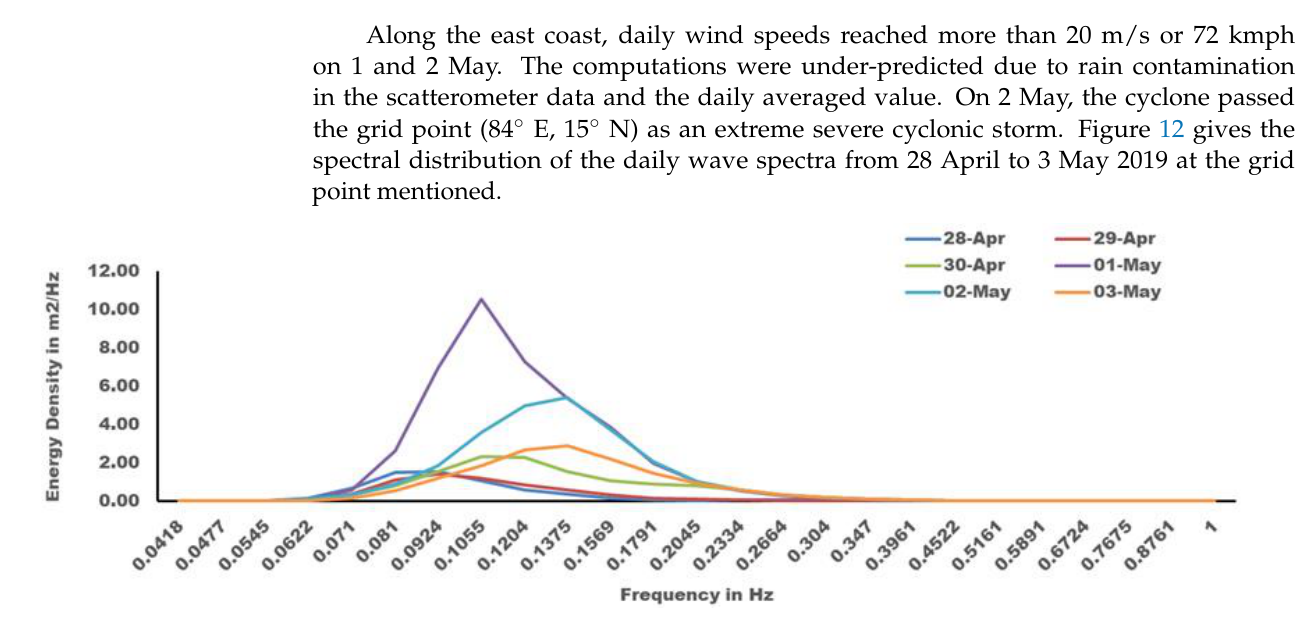
Figure 11. Computed SWH (m) for FANI cyclone from 1 to 3 May 2019 using SCATSAT-1 daily 25 km wind data.